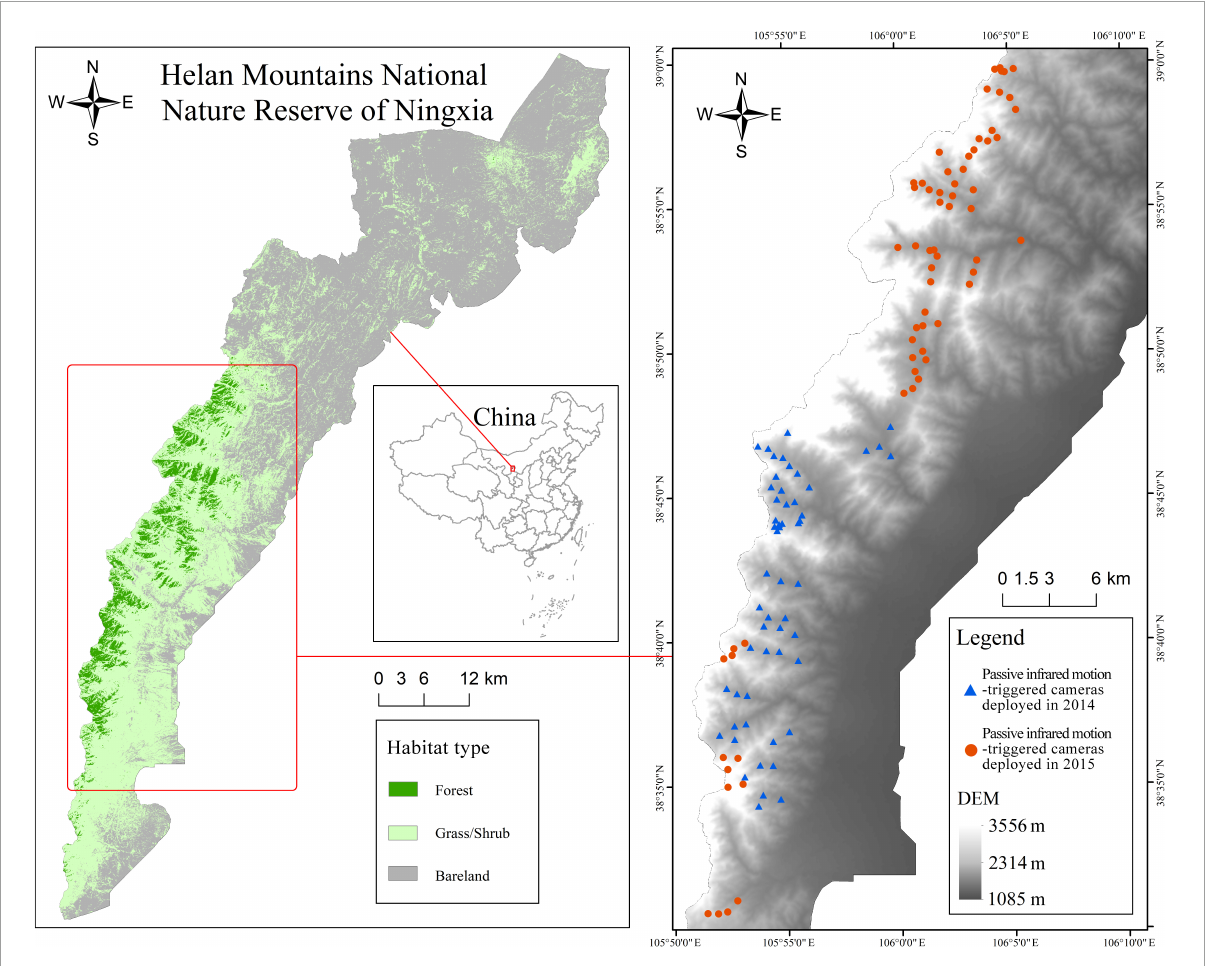
FIGURE1 Study area map depicting camera stations and vegetation covers (left, the location of Helan Mountains National Nature Reserve of Ningxia in China and its vegetation covers, which are represented by different colors; right, the location where the passive infrared motion-triggered cameras were deployed to monitor the activity of blue sheep and red